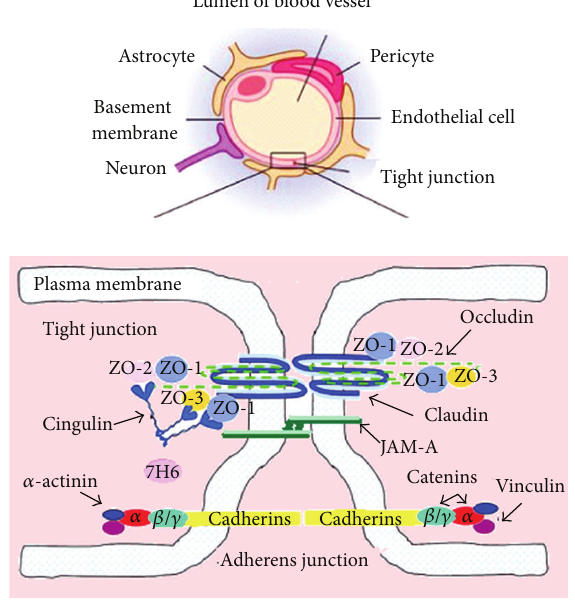
Figure 1: The structure of blood-brain barrier.